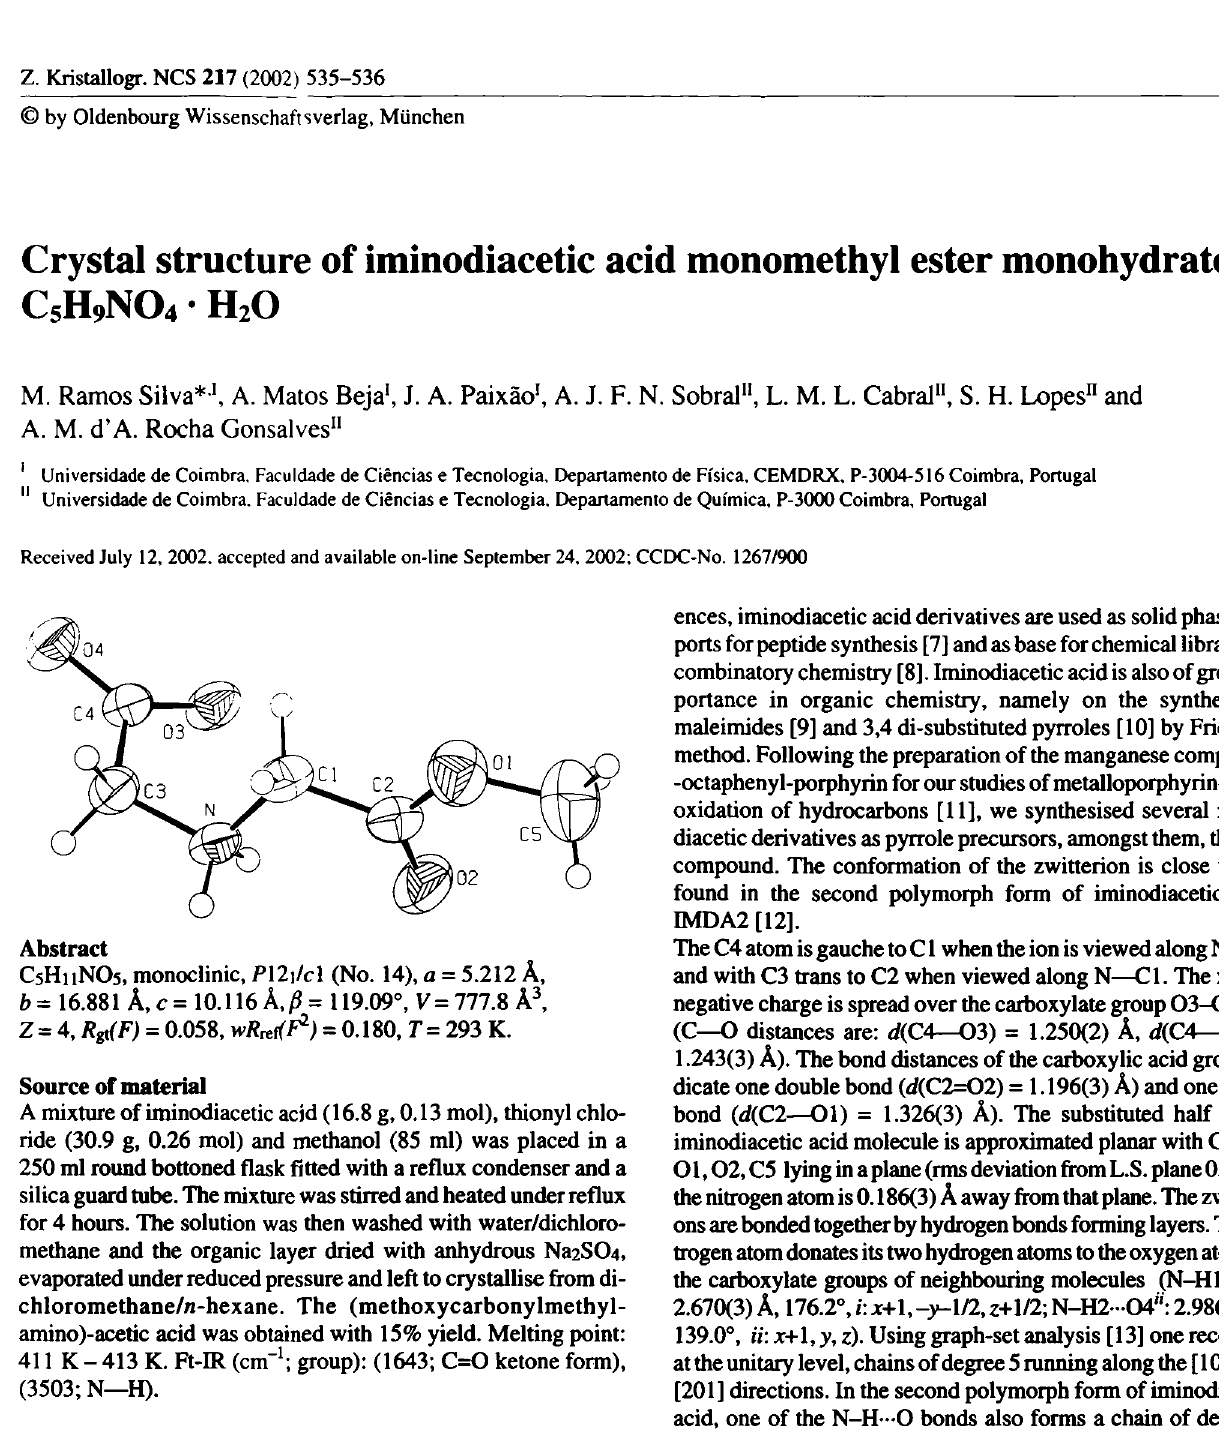
Table 1. Data collection and handling.